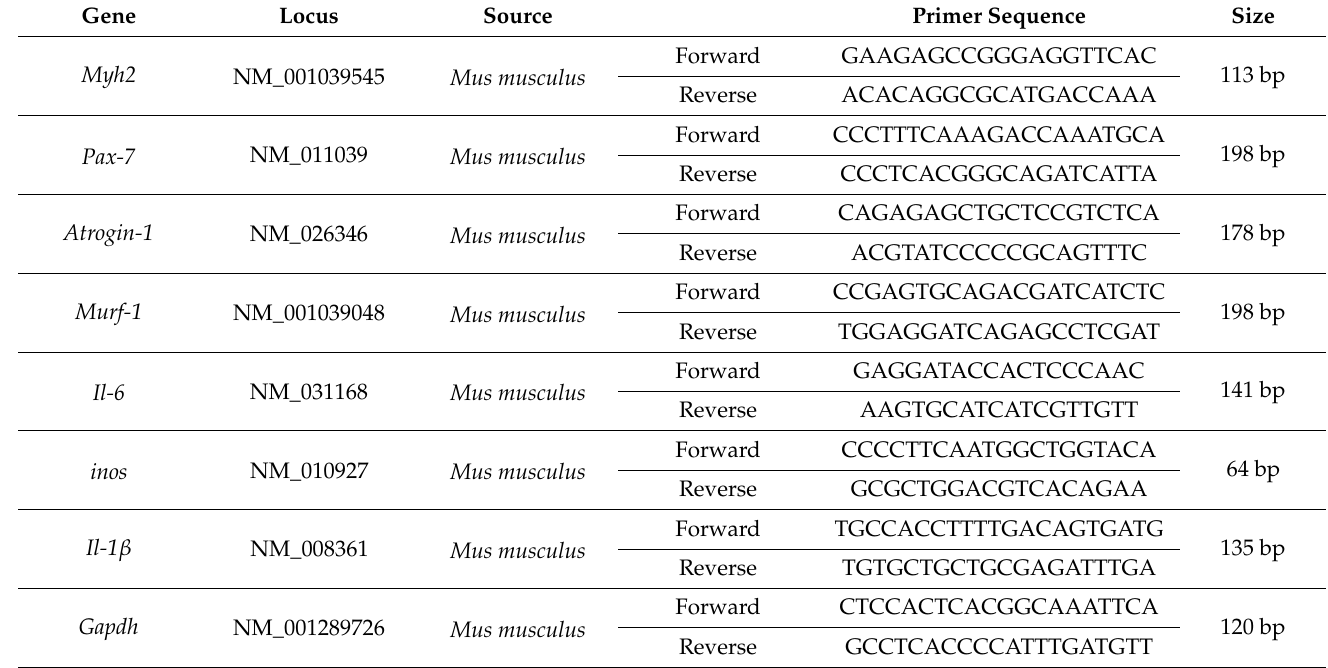
Table 1. qPCR primers used in this